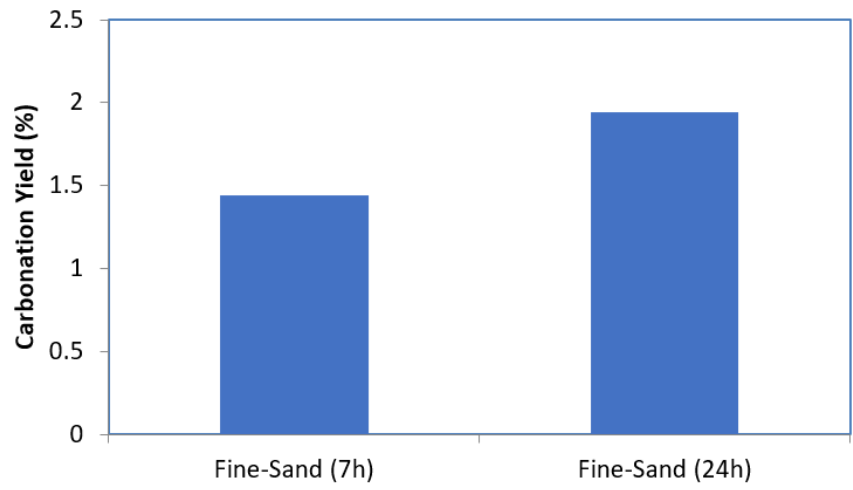
Figure 7. Carbonation yield at 2 bar pressure, 7 and 24 h carbonation times, 110 and 120 h curing times.